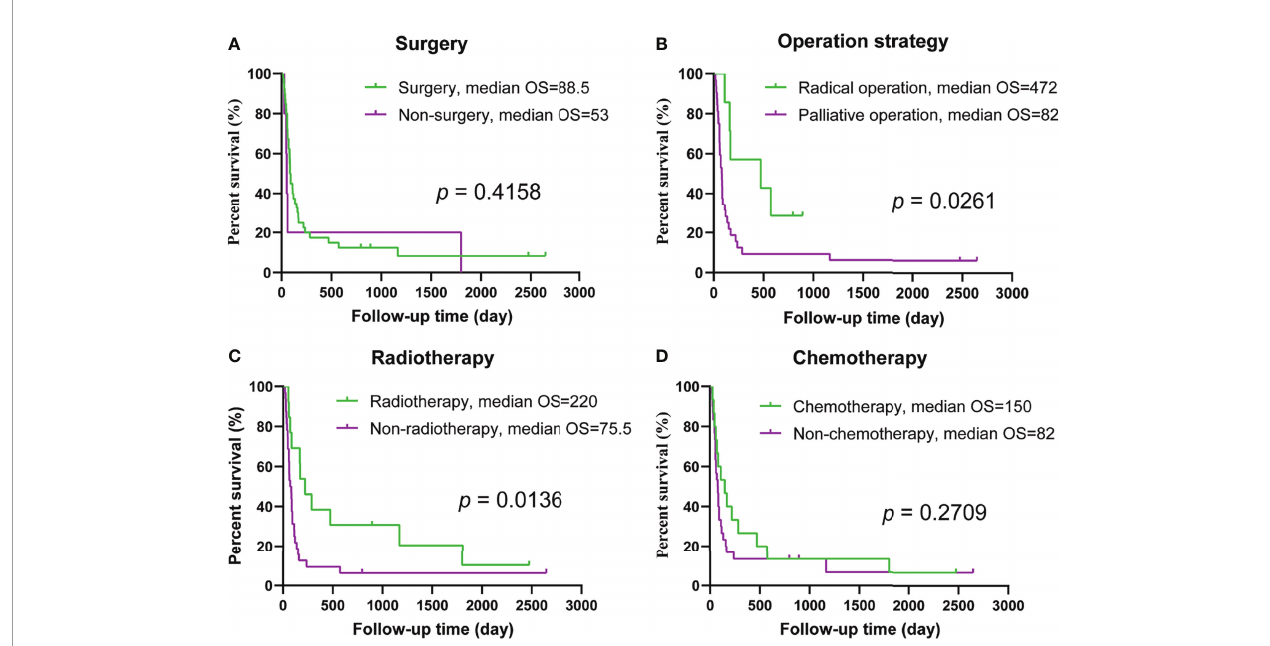
FIGURE 2 | Prognosis analysis of single treatment strategy. (A) Overall survival (OS) in patients with and without surgery. (B) OS in patients undergoing radical surgery and palliative surgery. (C) OS in patients treated with and without radiation therapy. (D) OS in patients with and without